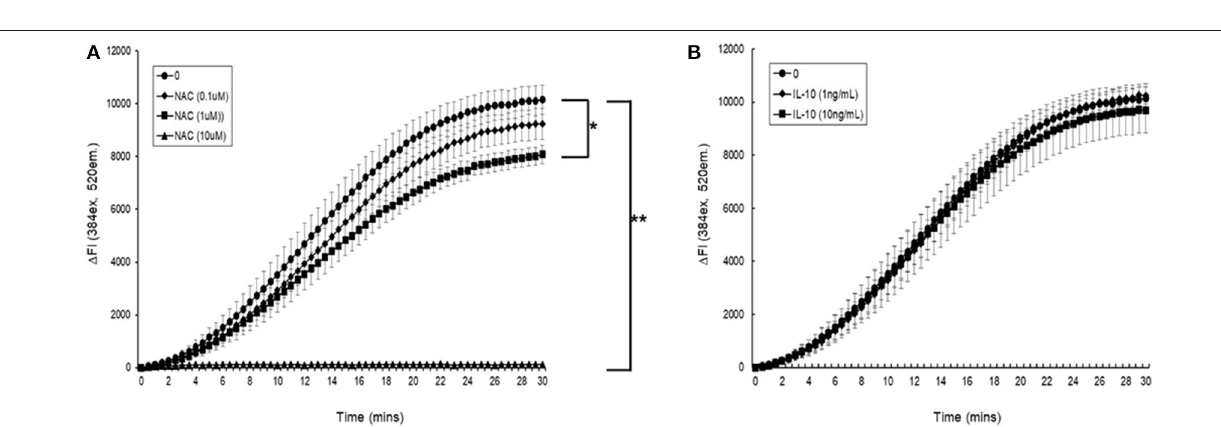
FIGURE 6 | The direct effect of (A) N-acetyl cysteine (NAC) or (B) IL-10 on AAPH-stimulated reactive oxygen species (ROS) generation in a mouse differentiated myotubule cell-line. Results are presented as a change in fluorescence intensity ( 1 FI, excitation [Ex.] 384nm, emission [Em.] 520nm) ( 1 FI) over 30min. Results are mean ± SEM of five separate experiments. * p < 0.05 and ** p < 0.001 represents statistical difference from AAPH